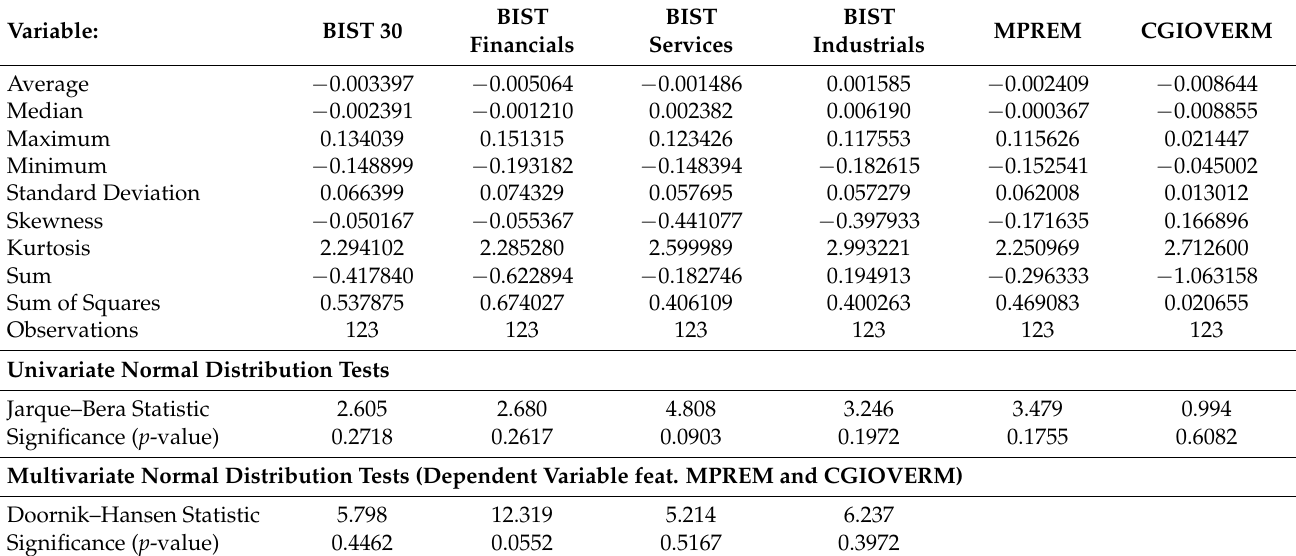
Table 1. Descriptive statistics and distribution